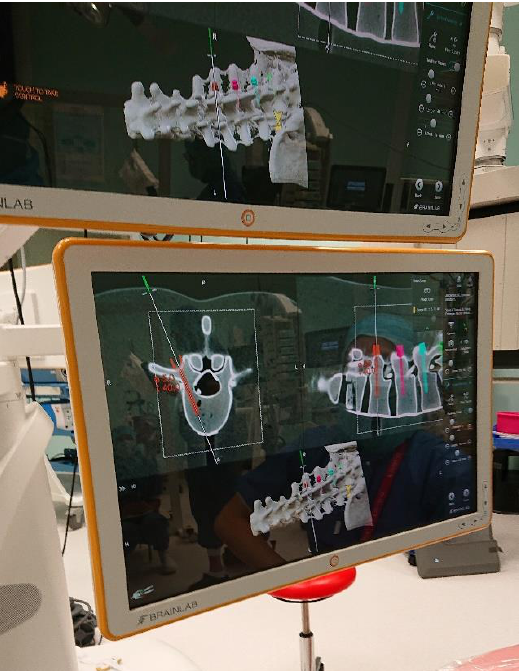
Figure 2. The screens of the navigation system present information corresponding to the surgeon’s view in the HMD.